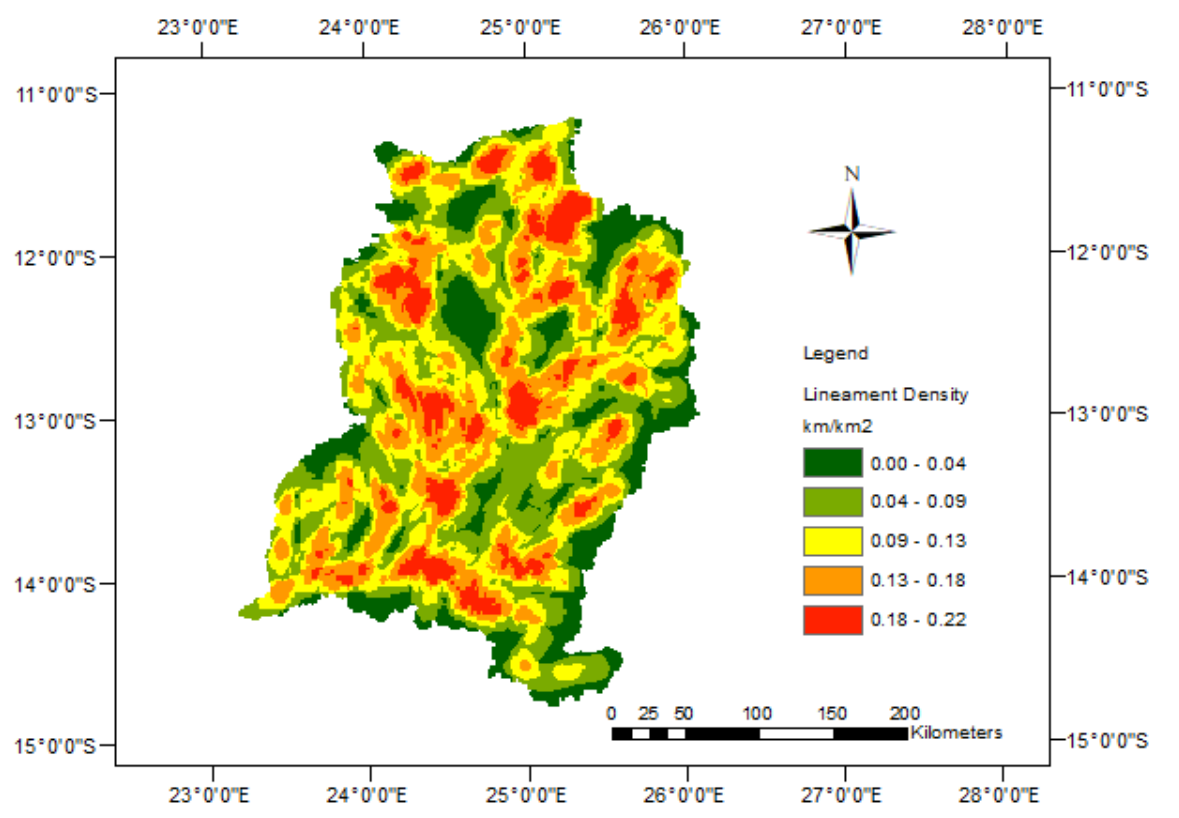
Figure 5. Lineament density map of Kabompo catchment.